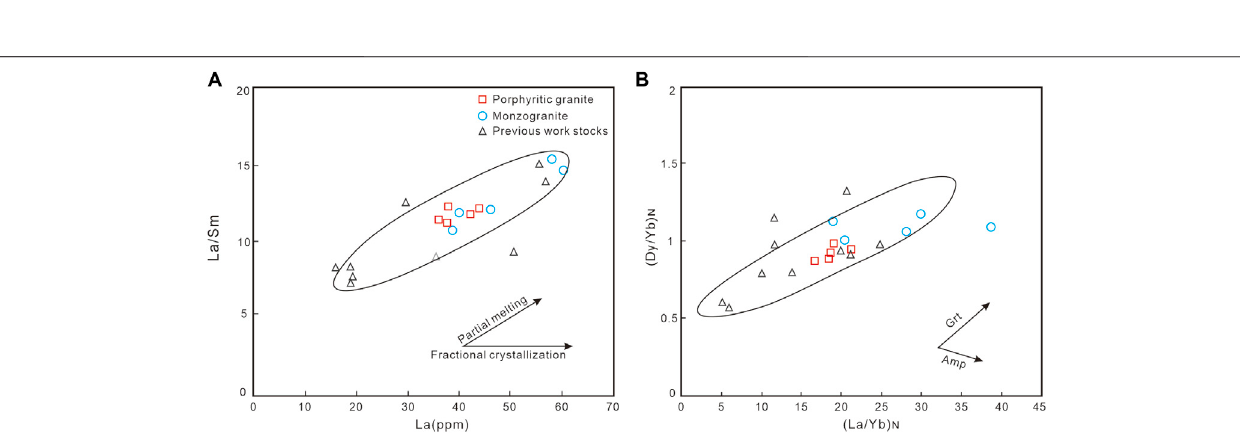
FIGURE 8 | La-La/Sm diagram (A) and (La/Yb) N vs (Dy/Yb) N diagram (B) of Yaozhuang stocks and [ (A , B) after He et al., 2011; data after Ke et al., 2012a].